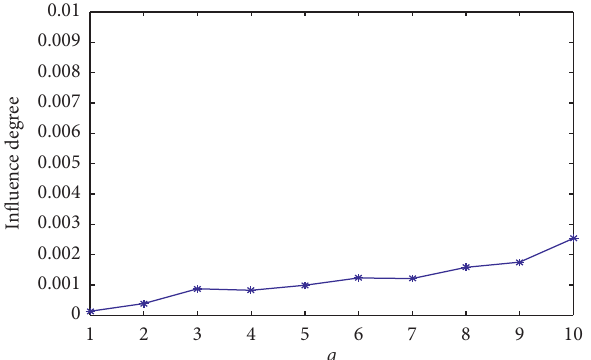
Figure 1: The effect of white noise sequence ξ of the two series X and Y